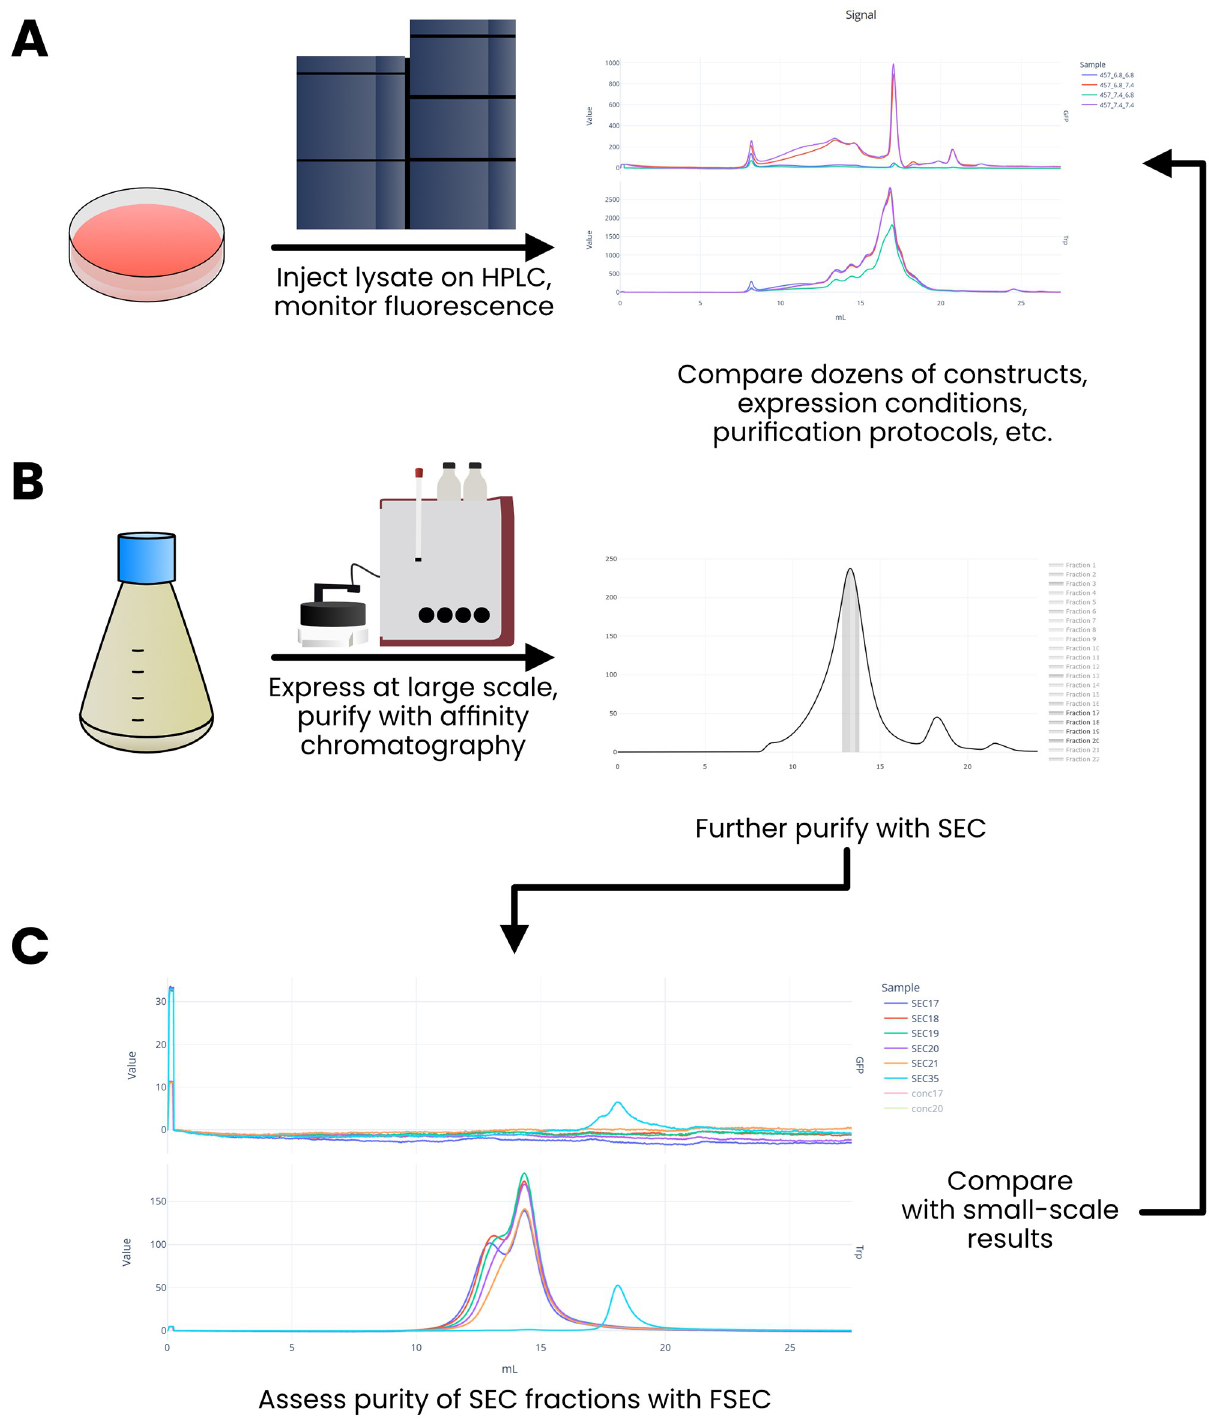
Fig 5. Paired SEC/FSEC. In a paired SEC/FSEC assay, small-scale purifications of varying constructs in varying conditions are analyzed by FSEC for monodispersity and yield (A). Next, conditions of interest are purified by affinity chromatography and preparative SEC (B). Fractions from each step are selected with Appia Web for re-analysis using analytic FSEC (C) to assess the homogeneity of the samples. These results can easily be compared with prior analytic work of other constructs or conditions without ever leaving the Appia Web interface.